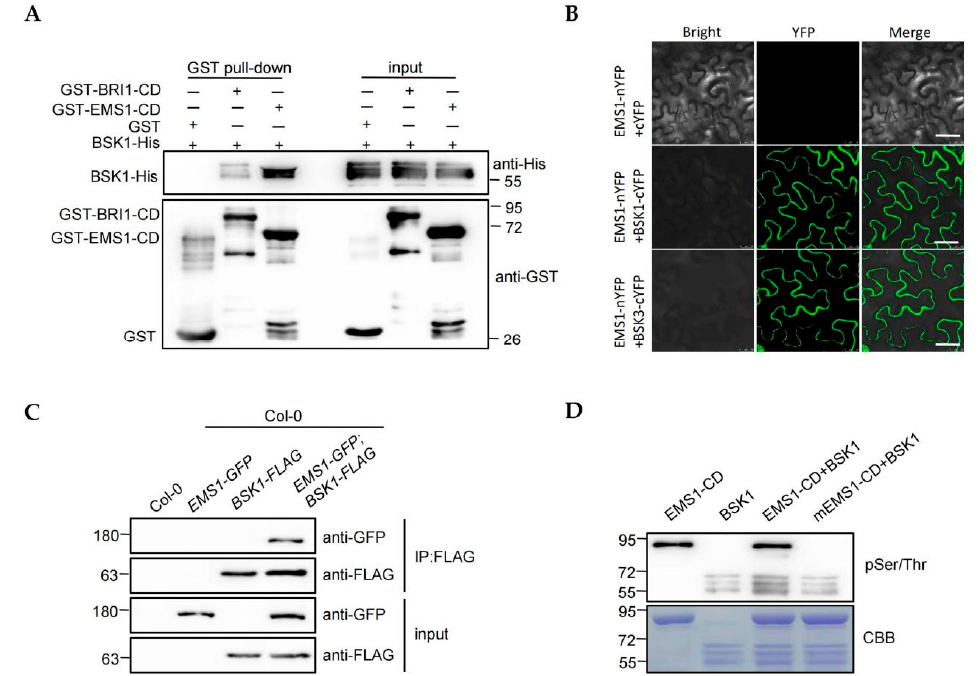
Figure 5. BSKs are the substrate of BRI1 and EMS1. ( A ) Pull-down assays showed BRI1 and EMS1 could interact with BSK1, respectively. GST, GST-BRI1-CD, and GST-EMS1-CD were immobilized on GST beads, incubated with BSK1-His protein, and immunoblot analysis is detected with His antibody and GST antibody. ( B ) BiFC assays showed the interaction of EMS1 with BSK1 and BSK3. The EMS1-nYFP was coexpressed with cYFP, BSK1-cYFP, and BSK3-cYFP in N. benthamiana , respectively, after 2 days being visualized under confocal microscopy. cYFP and nYFP represent the C-terminus and N-terminus of YFP, respectively. The EMS1-nYFP+cYFP is the negative control, Scale bar, 50 µ m. ( C ) EMS1 interacts with BSK1 in vivo. Total protein was extracted from 1-week-old Col-0, EMS1-GFP /Col-0, BSK1-FLAG /Col-0, and EMS1-GFP ; BSK1-FLAG /Col-0 seedlings, immunoprecipitated with anti-FLAG M2 affinitygel, and then analyzed by GFP antibody and FLAG antibody. ( D ) EMS1 kinase domain phosphorylates BSK1 in vitro. The kinase assays were performed using EMS1-CD- MBP, mEMS1-CD-MBP, and BSK1-His. Top panel, Phosphorylation analyzed by pSer/Thr. Bottom panel, the gel stained with